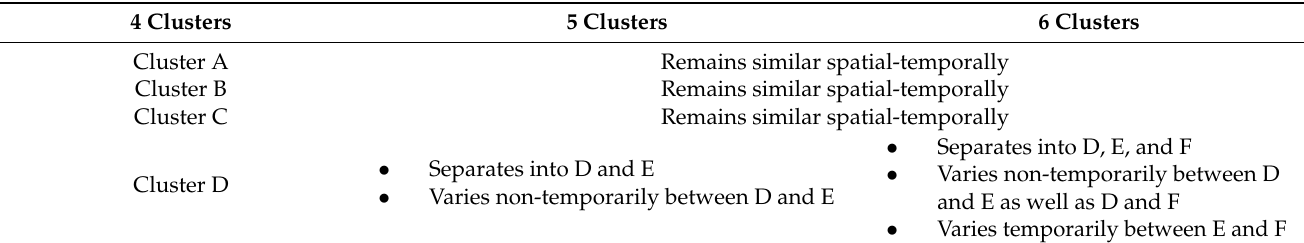
Figure 6. Comparing temporal crime patterns for the STICA results with four, five, and six clusters. ( a ) Cluster As in the STICA results; ( b ) Cluster Bs in the STICA results; ( c ) Cluster Cs in the STICA results; ( d ) Cluster D in the four-cluster result and Cluster D & E in the five-cluster result; ( e ) Cluster D in the four-cluster result and Cluster D, E, & F in the six-cluster result. Table 1. Comparing the STICA results with four, five, and six clusters.